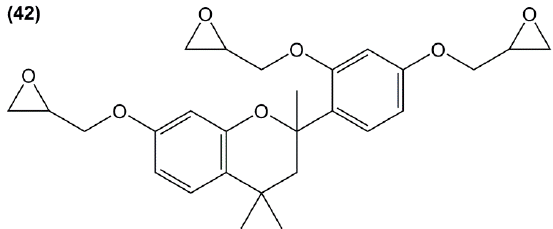
Figure 25. Triglycidyl ether derivative based on resorcinol and acetone.